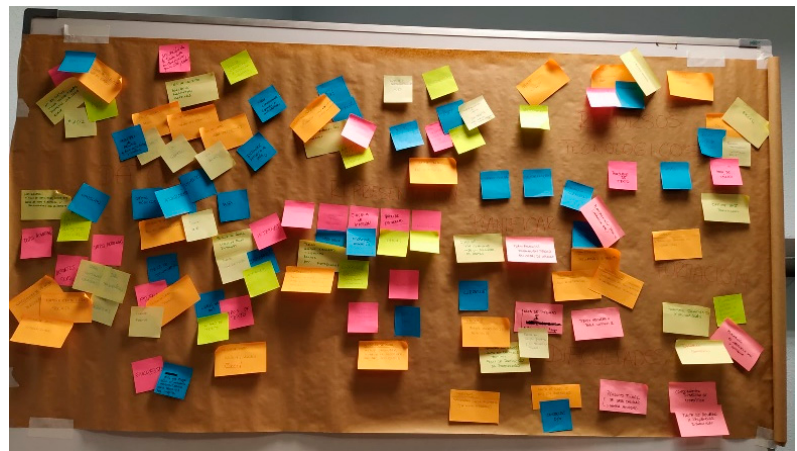
Figure 4. Result of the Metaplan ® [39] moderation method that was used during the first session.